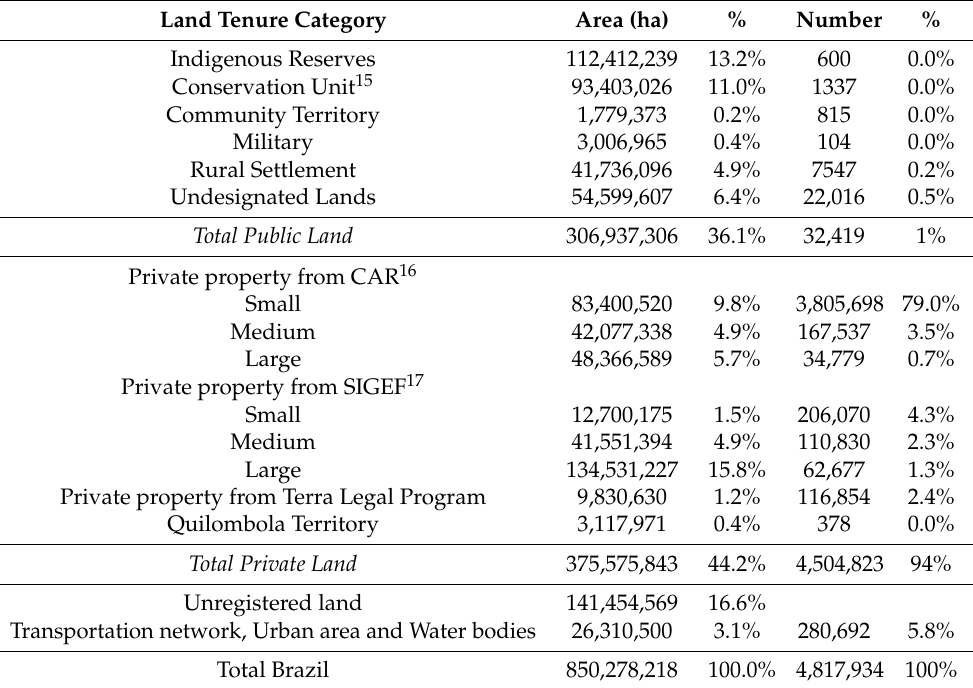
Table 2. Area and number of units of Brazilian land tenure categories